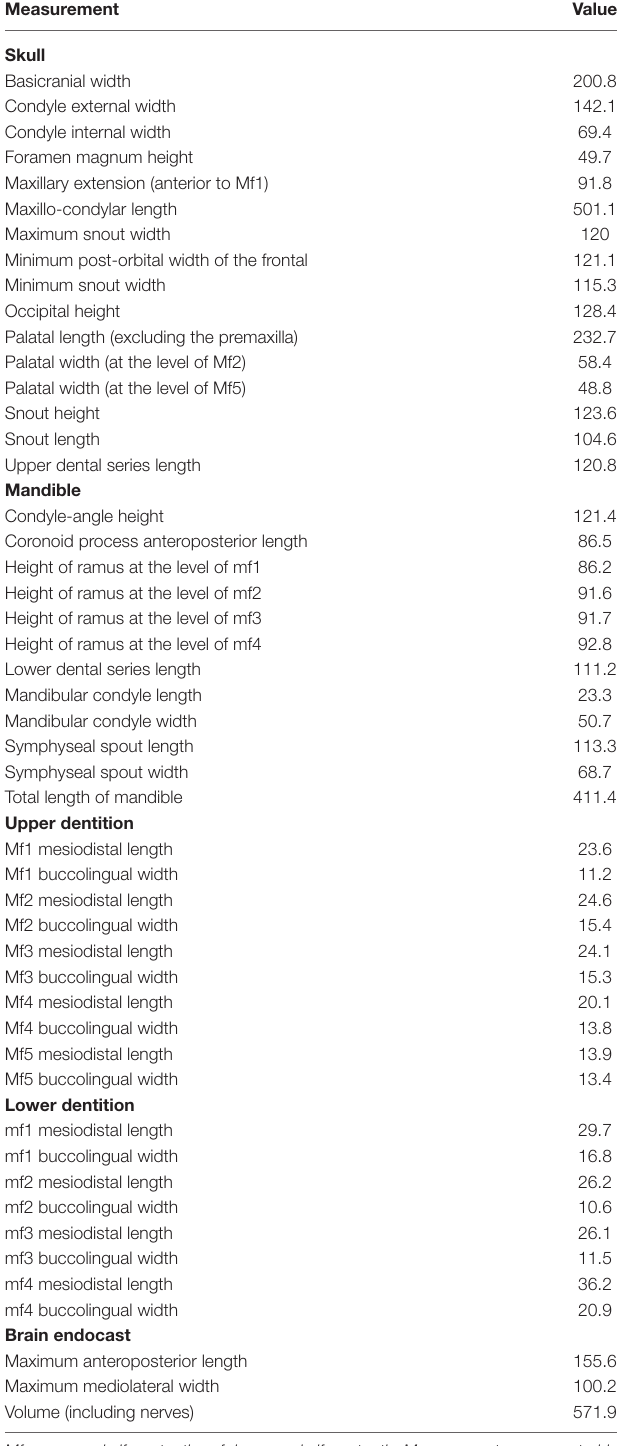
TABLE 1 | External and internal measurements of the craniodental remains of Catonyx tarijensis MNHN-Bol V 13364 from the Pleistocene of Oruro (Bolivian